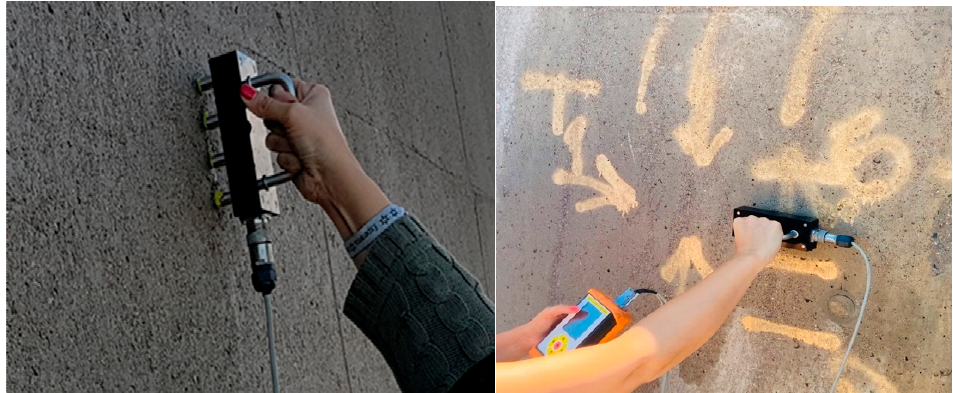
Figure 8. Electrical resistivity measurements with a Wenner probe equipment.